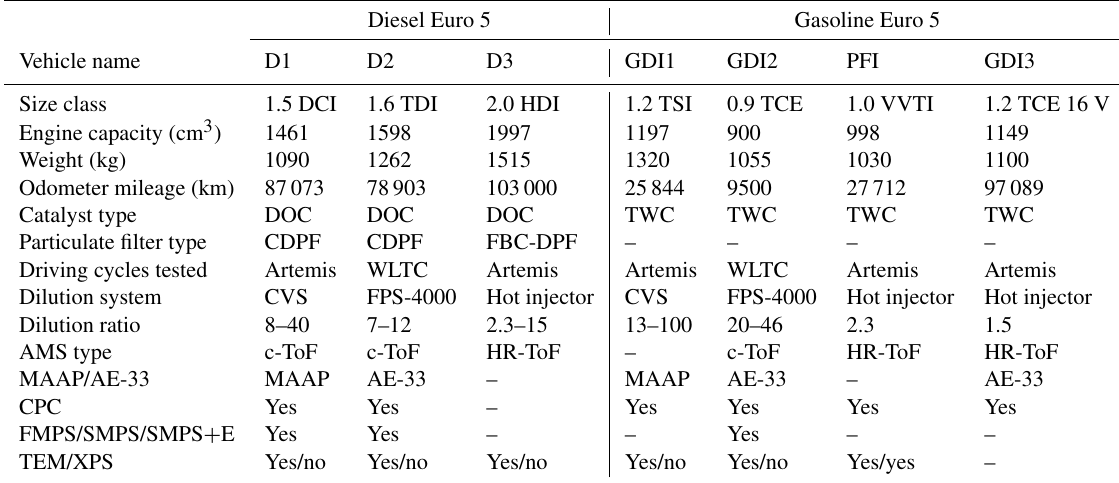
Table 1. Technical characteristics of the tested vehicles, experimental conditions, and particle-phase instrumentation